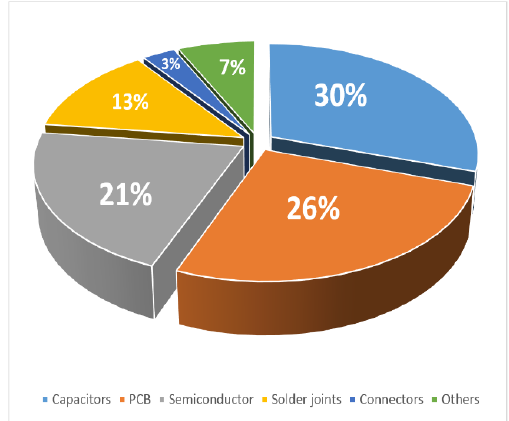
Figure 1. Failure-root-cause summary of power electronic systems.